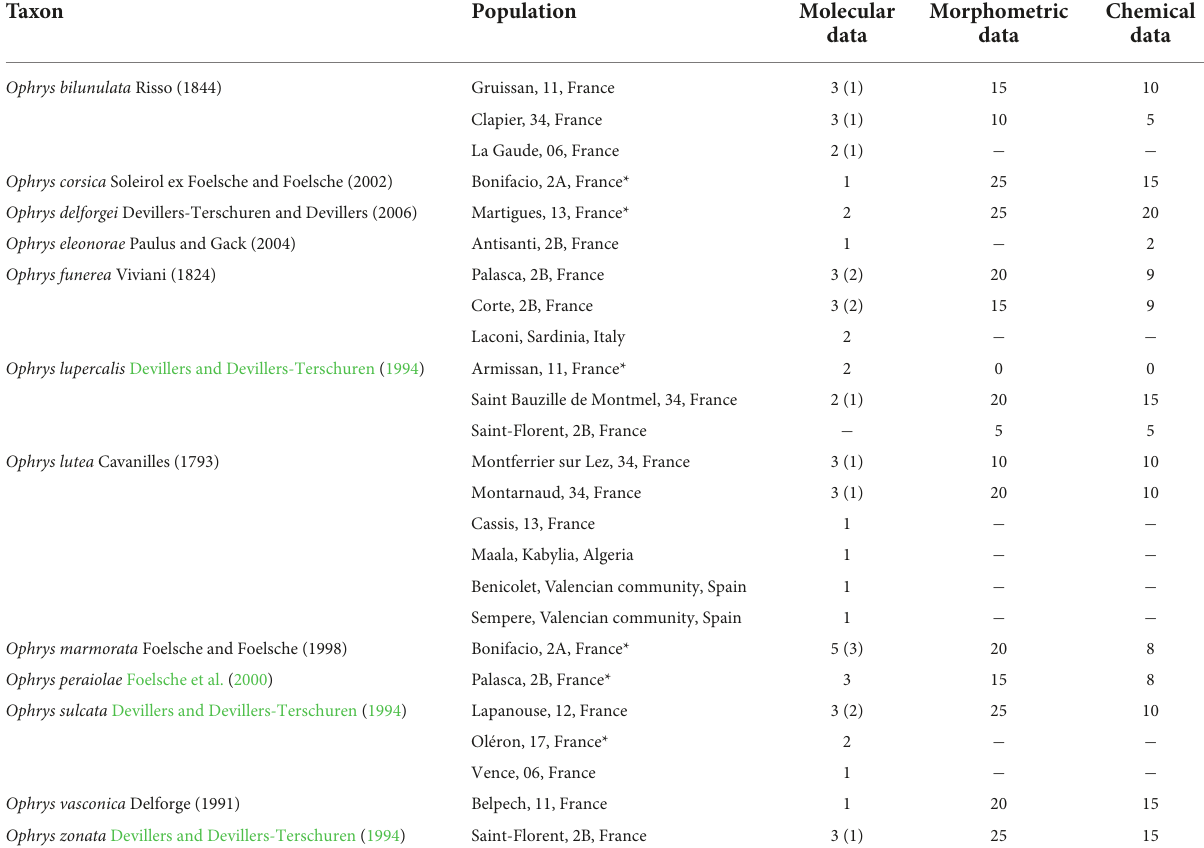
TABLE 1 Number of populations and individuals sampled for molecular, morphometric, and chemical data.